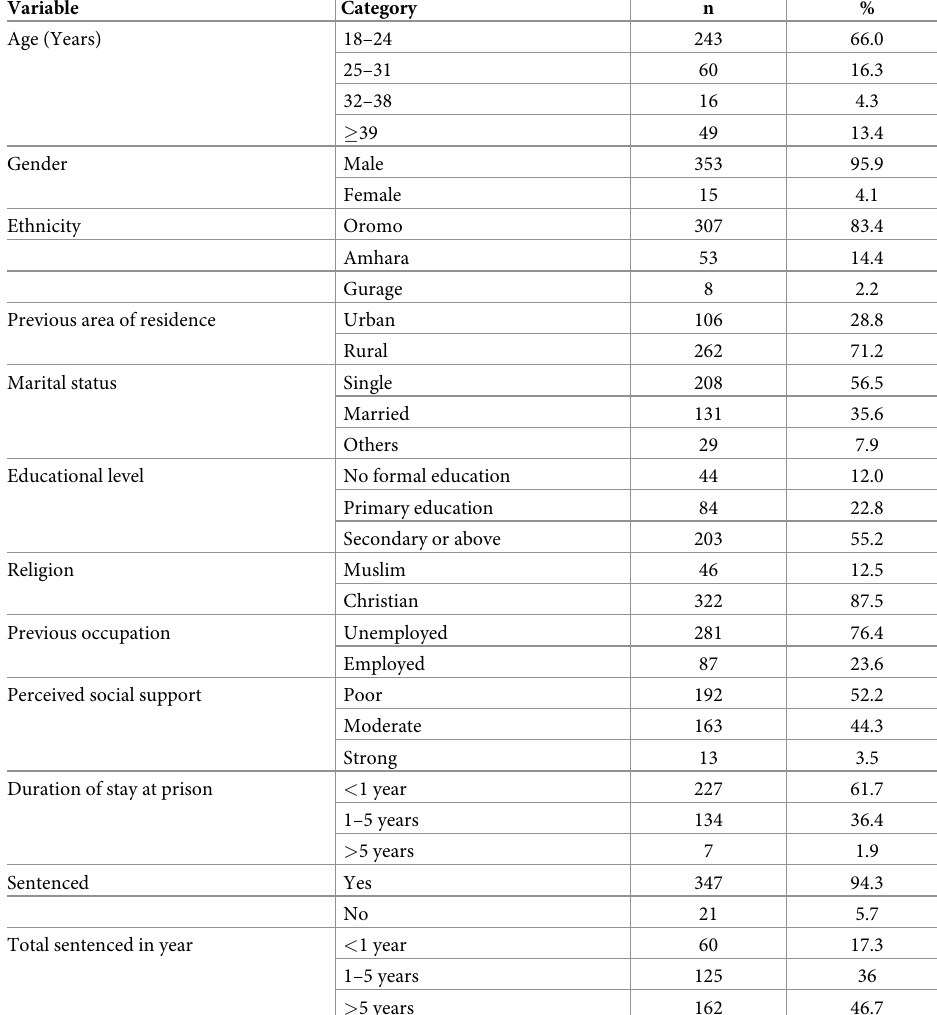
Table 1. Characteristics and percentage distribution of the of prisoners in Wollega zones of Oromia, Ethiopia,